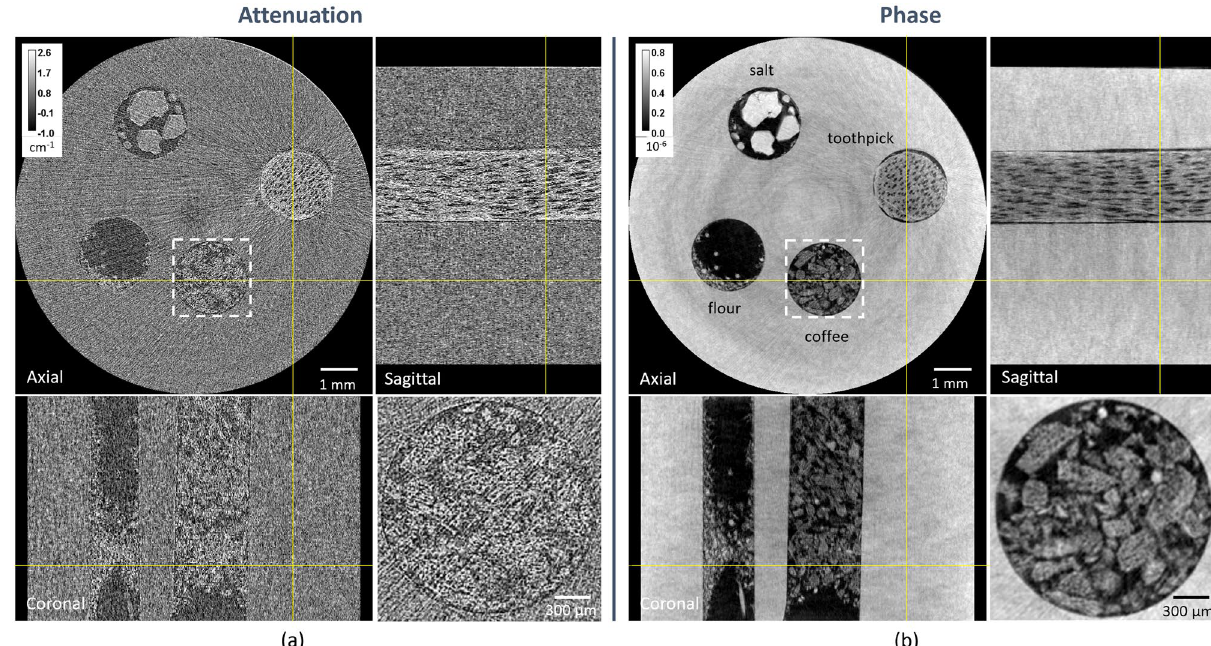
Figure 9. CT images of the plastic phantom with inserts acquired in the double-mask imaging modality. In ( a , b ) axial, sagittal, and coronal views of the attenuation and (integrated) phase channels, respectively. Dashed boxes in the axial views identify the zoomed-in coffee powder detail of shown at the bottom-right of each